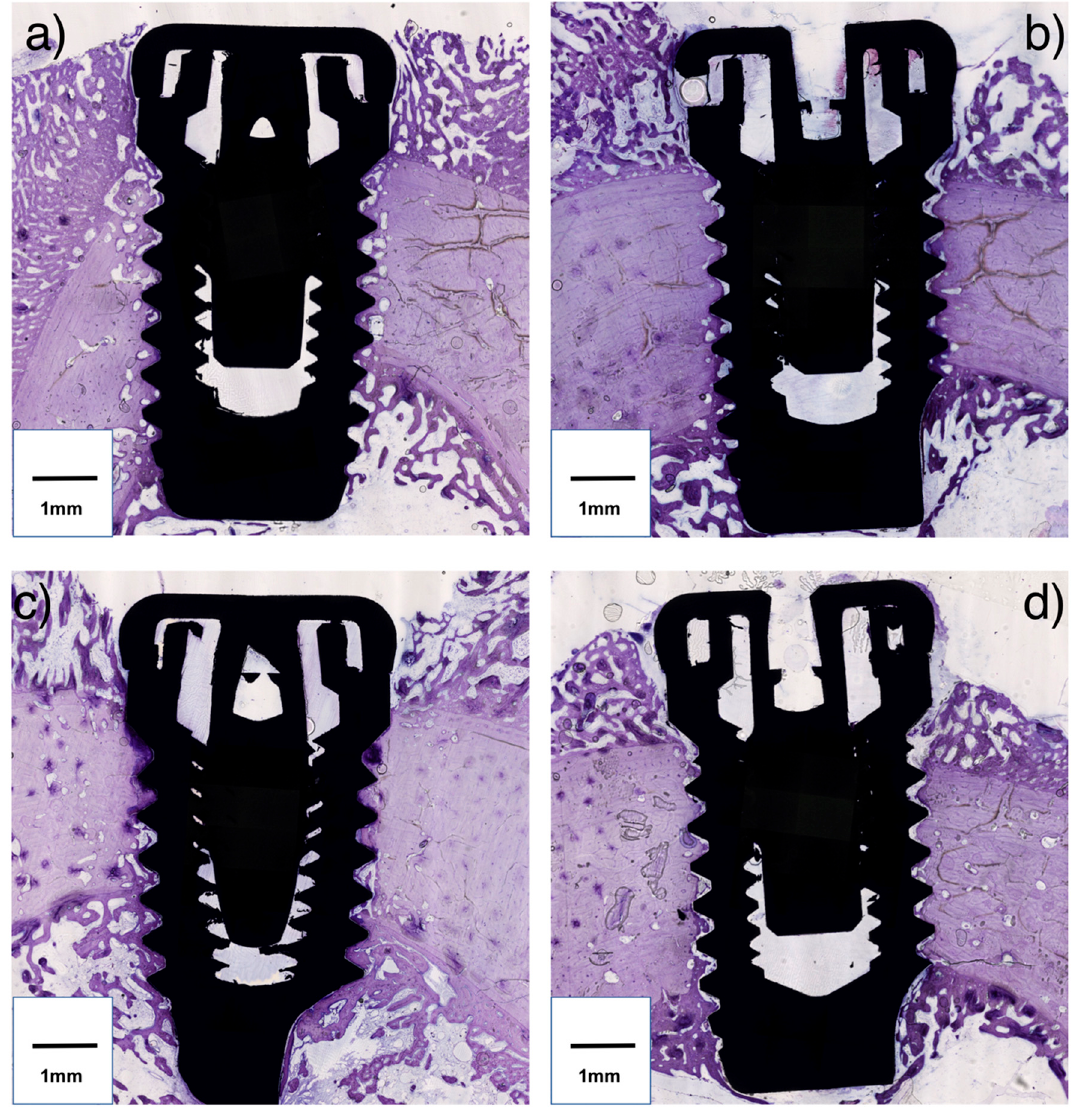
Figure 3. Histologic sections of the implant and peri-implant bone (original magnification 20 × ). Representations of group A, B, C, and D are depicted in ( a ), ( b ), ( c ), and ( d ), respectively. Mean values and standard deviation for BIC, BAFO, and BA1.5 are presented in Figure 4.